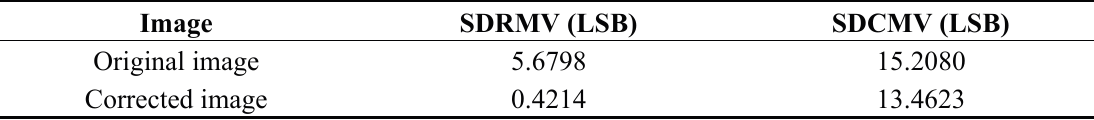
Table 2. Comparison of objective evaluation indexes of the uniform-light